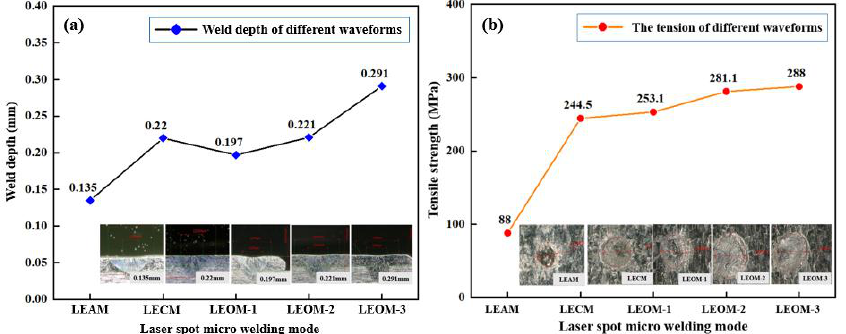
Figure 12. ( a ) Welding depth of different waveforms after and before optimization. ( b ) The tensile strength of different waveforms after and before optimization.